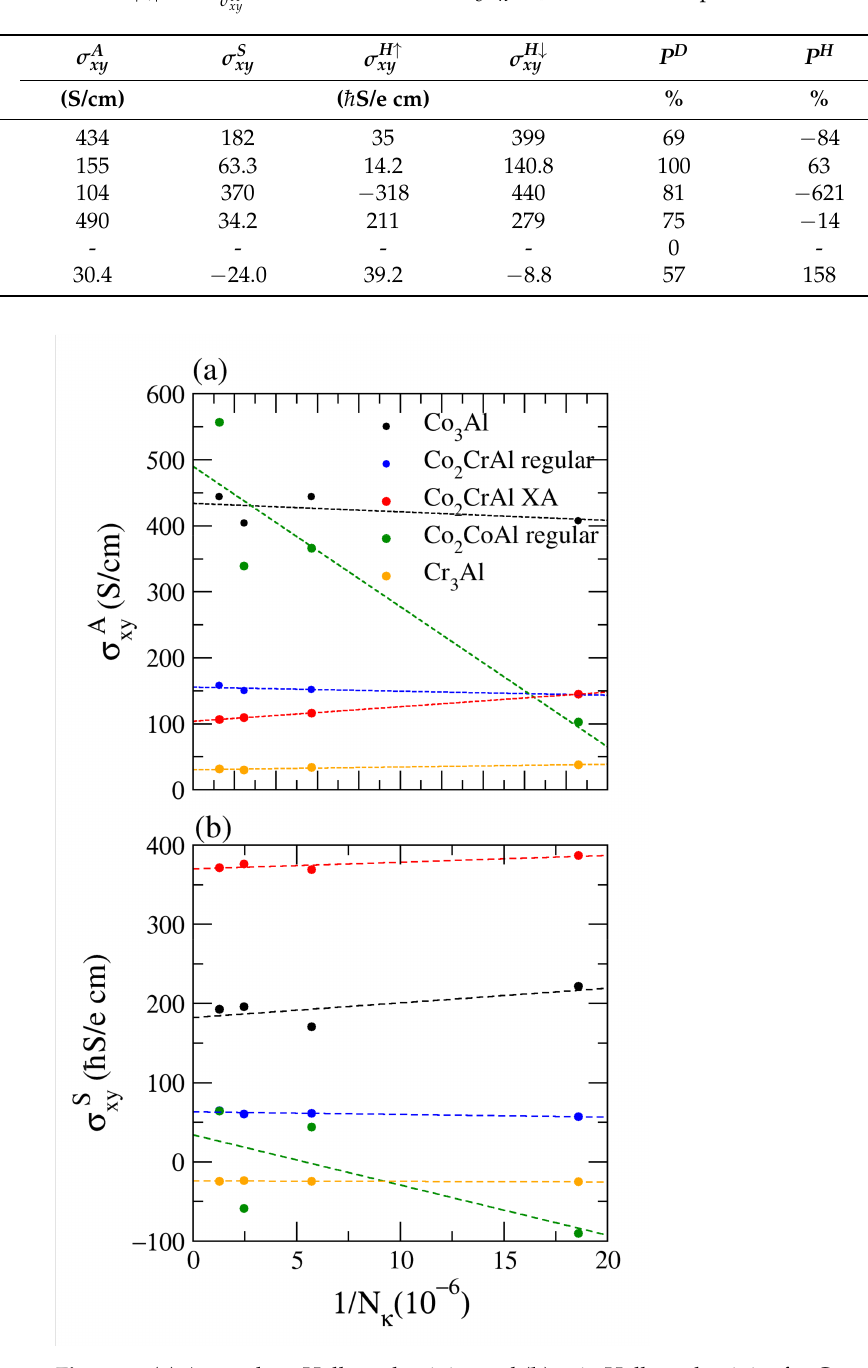
Table 4. Calculated anomalous Hall conductivity σ A xy (S/cm), spin Hall conductivity σ S xy ( (cid:125) S/e cm), spin polarization P D (%), Hall P H (%) current spin polarization and ratio of spin current to charge